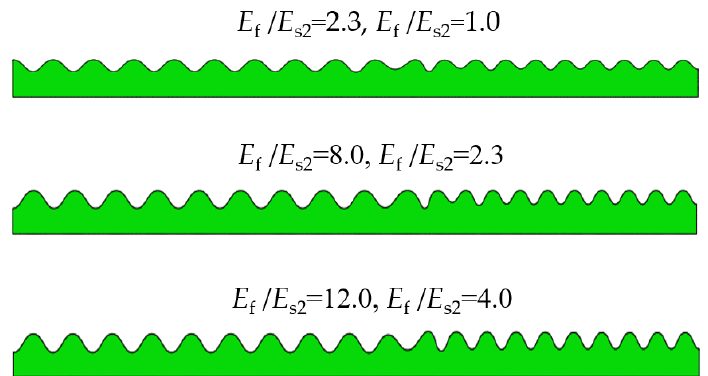
/ E on the composite instability morphology. f s 2 . / E f s 2